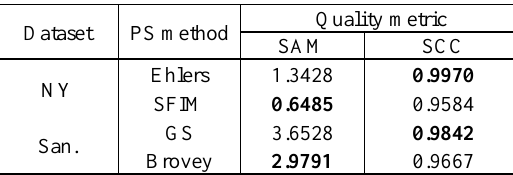
Table 3. The results of spectral and spatial quality